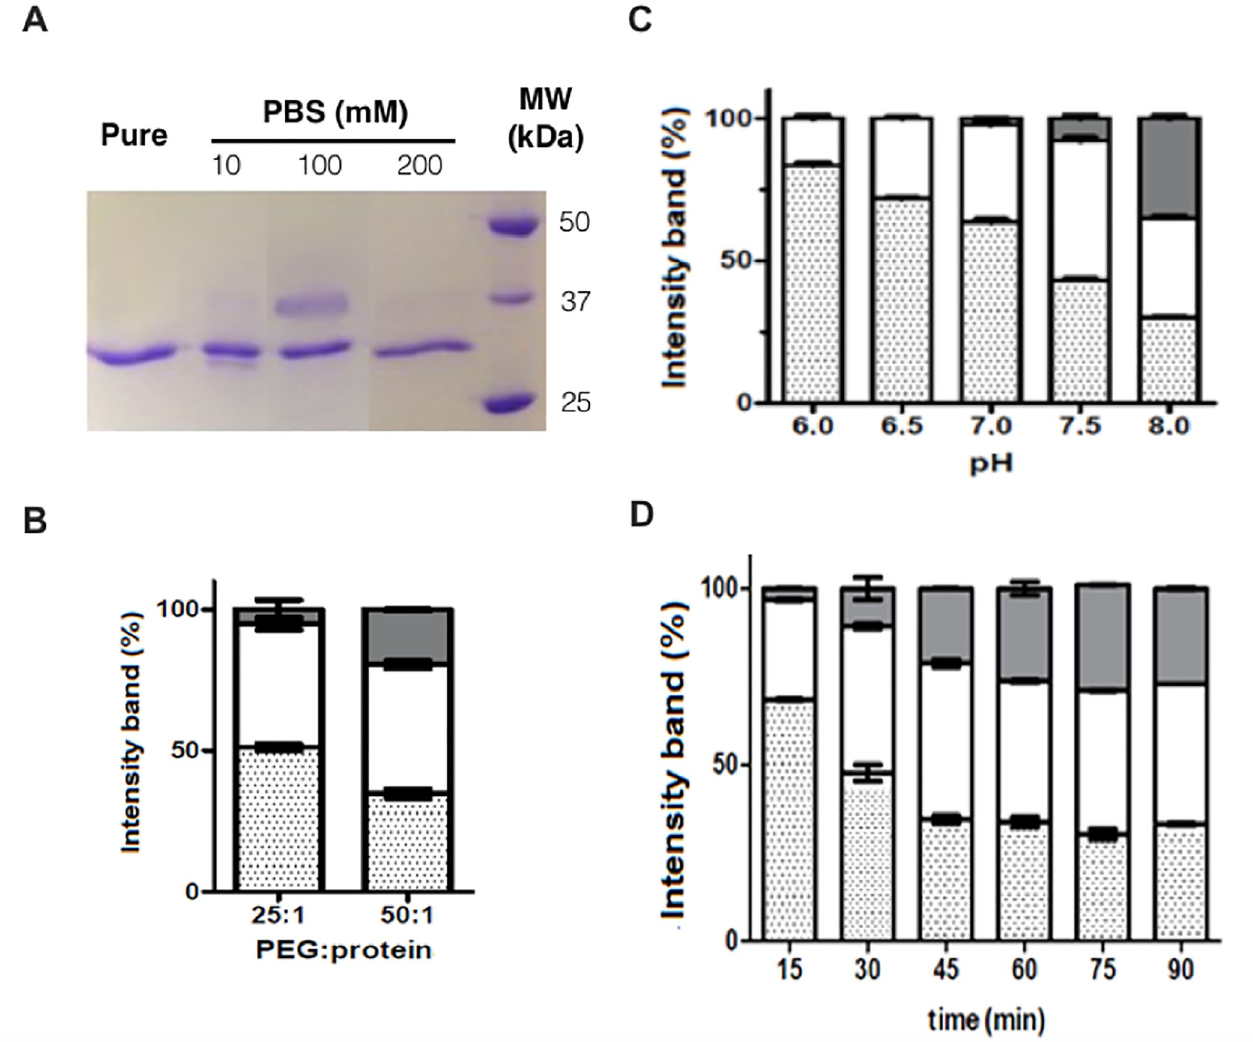
Fig 1. Reaction conditions to produce monoPEGylated L-asparaginase (monoPEG-ASNase). ( A ) Electrophoresis (SDS-PAGE) showing the influence of PBS buffer ionic strength on N-terminal PEGylation with pH 7.5 (PEG:ASNase ratio of 25:1, 2 kDa mPEG-NHS): Column 1- ASNase (control), column 2- reaction in 10 mM PBS, column 3- reaction in 100 mM of PBS, column 4- reaction in 200 mM PBS, and column 5- Molecular weight (BioRad). ( B ) Percentage of PEGylation at different PEG:ASNase ratios, 25:1 and 50:1, in 100 mM of PBS pH 7.5, 30 min of time reaction. ( C ) Percentage of PEGylation at different pH values (6.0, 6.5, 7.0, 7.5 or 8.0) in 100 mM of PBS, PEG:ASNase ratio of 25:1 and 30 min of reaction time. ( D ) Percentage of PEGylation on different reaction times (15 to 90 minutes) in 100 mM of PBS, pH 7.5, PEG:ASNase ratio of 25:1. Grey bars—polypegylated ASNase, white bars—monoPEGylated ASNase, dotted bars—free ASNase. Percentage of PEGylation was based on gel analysis by band